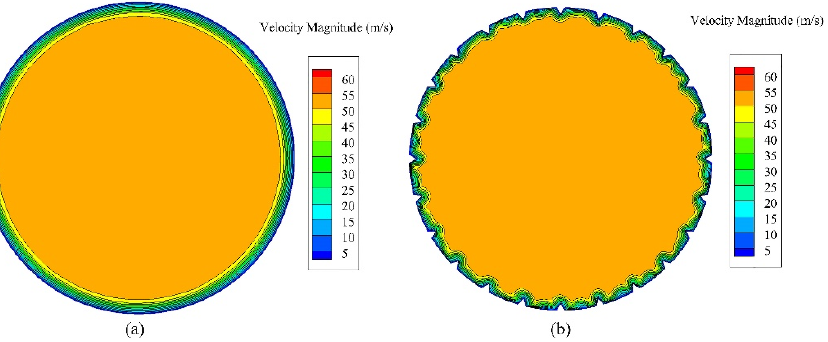
Figure 13. Comparison of pressure nephogram: ( a ) prototype and ( b ) bionic tailpipe.